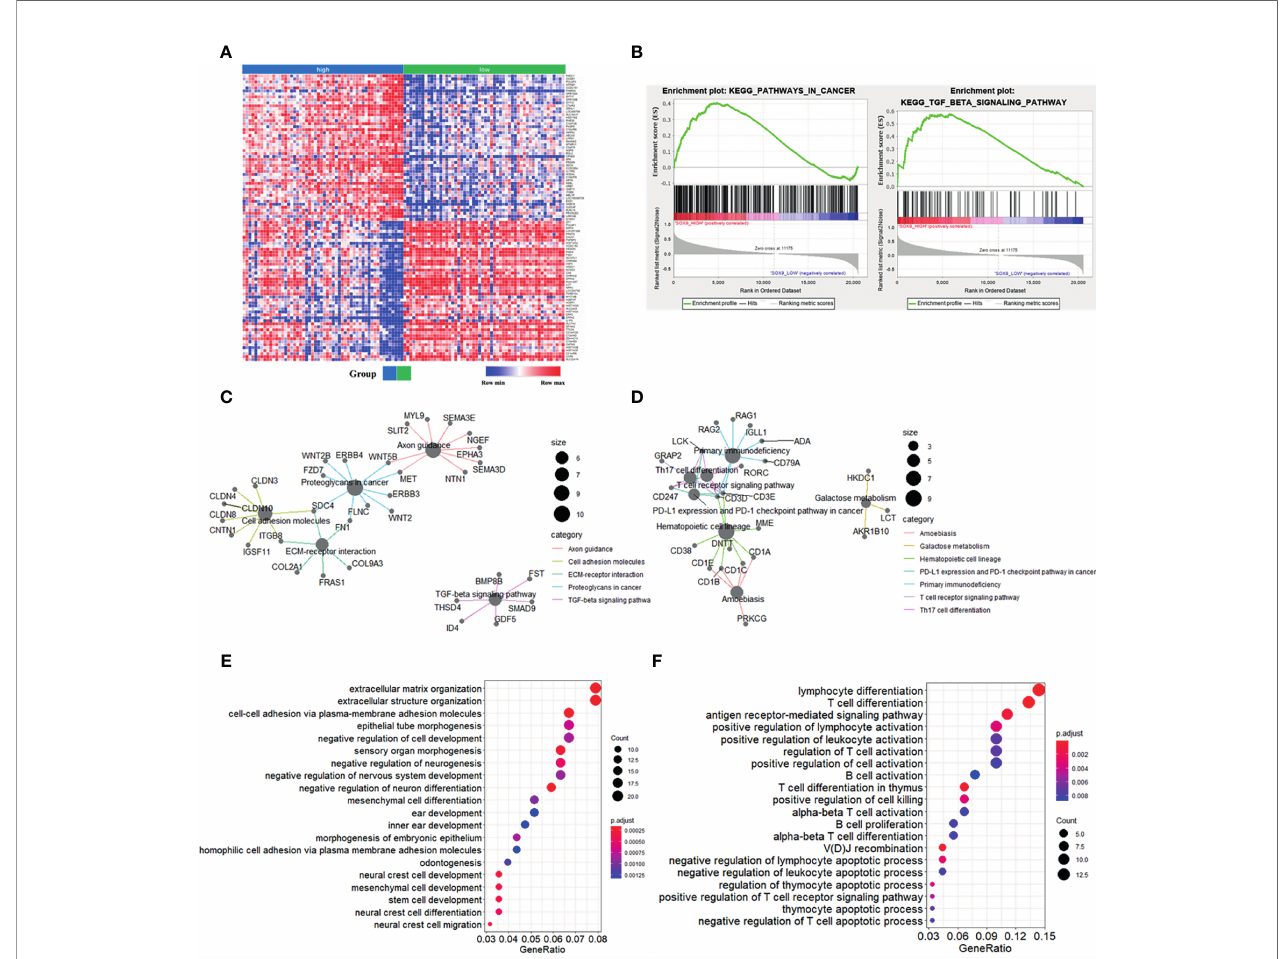
FIGURE 2 | Enrichment analyses of genes signi fi cantly correlated with SOX9 expression in thymomas. (A) Heat-map of the top 100 upregulated and downregulated genes determined by the Gene Set Enrichment Analysis (GSEA) analysis. (B) GSEA analysis revealed enrichment of the gene sets related to the “ pathway in cancer and TGF- b signaling pathway ” in patients with high SOX9 expression. (C) The cnetplot depicted the fi ve enriched Kyoto Encyclopedia of Genes and Genomes (KEGG) pathways detected and their associated differentially-expressed genes in thymoma patients with high SOX9 expression. (D) The cnetplot depicts the seven enriched KEGG pathways detected and their associated differentially-expressed genes in thymoma patients with low SOX9 expression. (E, F) The dot-plot depicts the activity of the biological processes terms in thymoma patients with high and low SOX9 expressions,